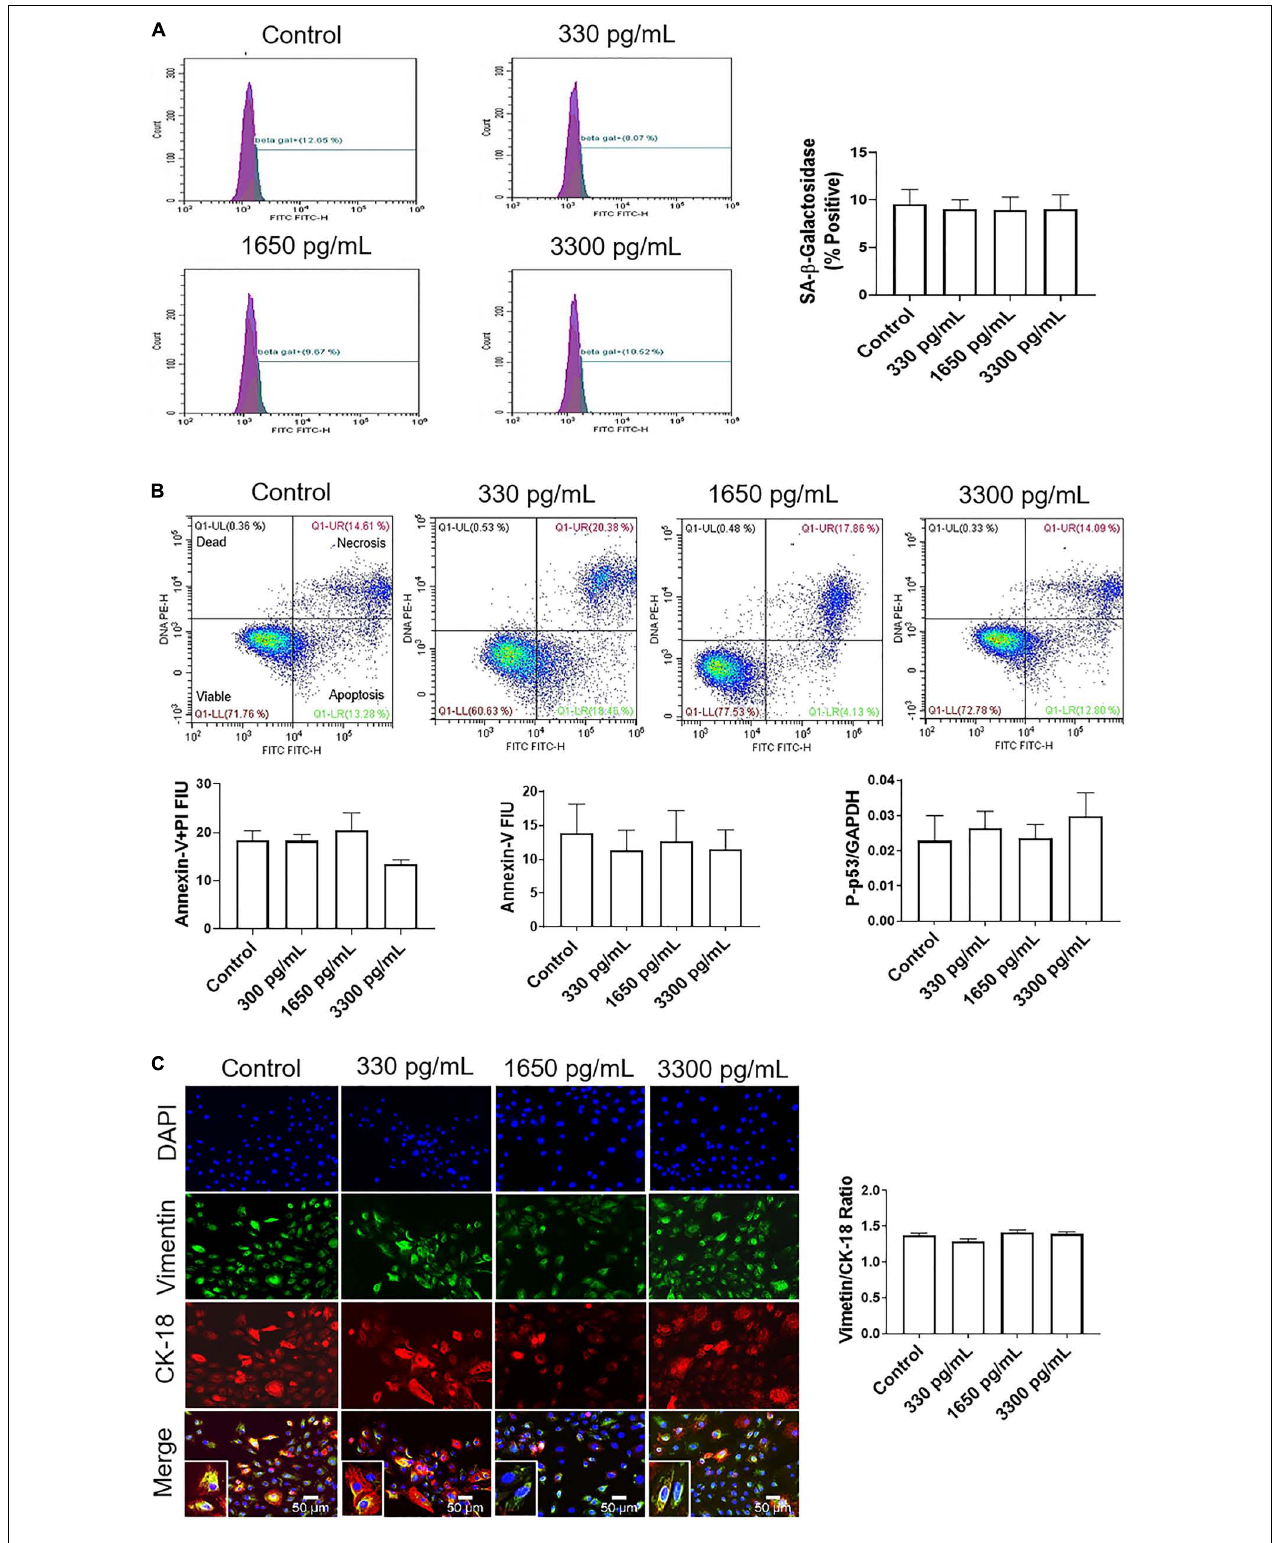
FIGURE 2 | IL-6 at term labor does not induce cellular aging, cell death, or cellular transitions in AECs. (A) Flow cytometry analysis of IL-6 induced senescence in AECs. Physiologic concentrations of IL-6 did not increase the population of senescence-associated- β -galactosidase (SA- β -Gal) cells compared to controls. N = 5;